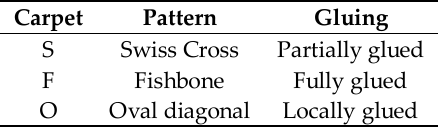
Table 1. Description of carpets examined: Pattern and way of gluing of each